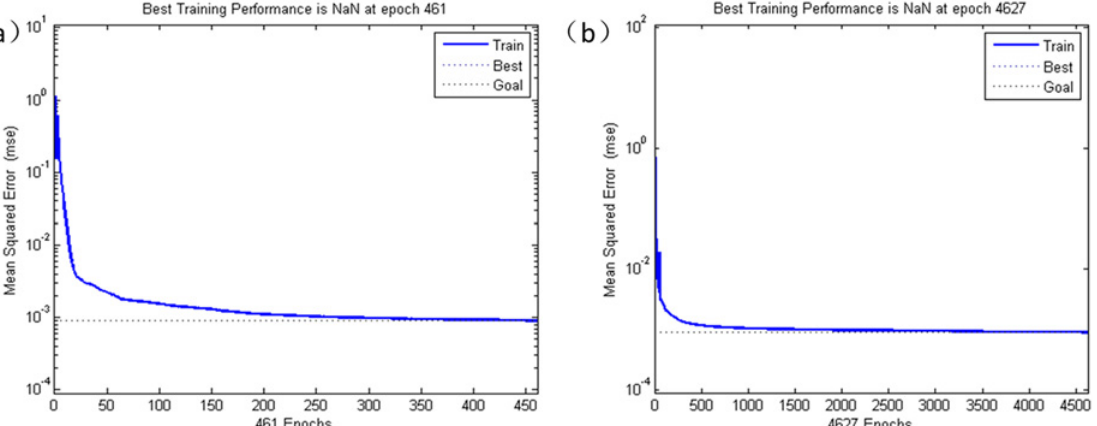
Fig 7. The training process of the BP network. (a)The (2D) 2 PCA+BPNN (DIM = 7×1 = 7) model converge after 461 epochs. (b)PCA+BPNN (DIM = 7) converges after 4627 epochs.